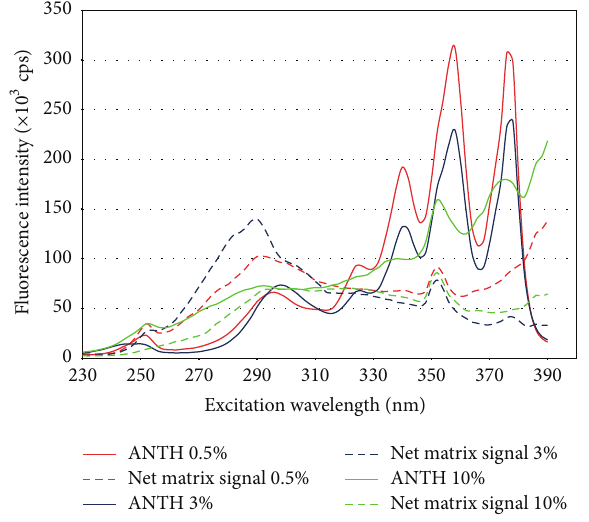
Figure 1: Excitation spectra with 𝜆 emission = 401 nm of the 22.5 ng/mL anthracene solutions and the net matrix signal fluores- cence intensity.